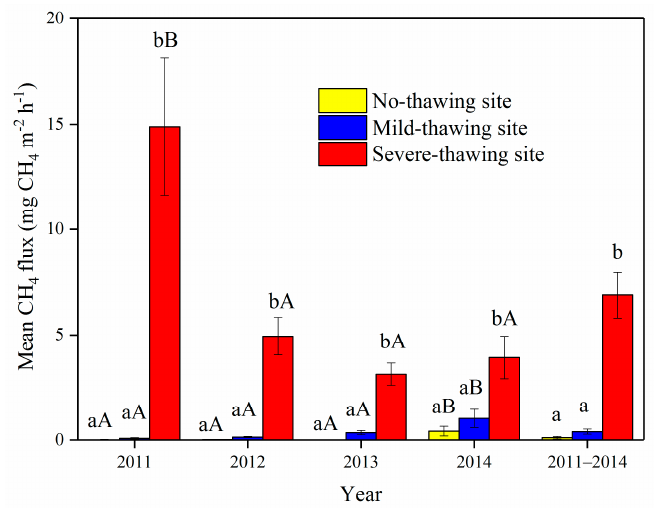
Figure 5. Mean CH 4 fluxes in different years and sampling sites. Data are means ± SE. n = 18 in 2011, n = 16 in 2012, n = 17 in 2013 and 2014. Different lowercase letters indicate the significant differences among sites in the same year or the mean of the four years. Different capital letters indicate the significant differences in the same site between different years.